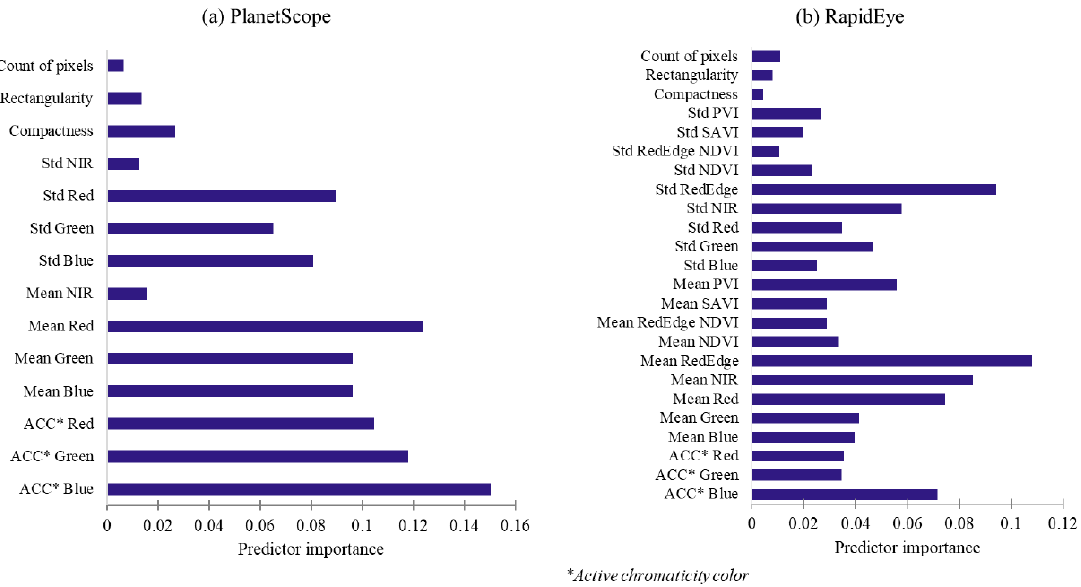
Figure 5. Variable importance for linear feature classification. ( a ) PlanetScope and ( b ) RapidEye.